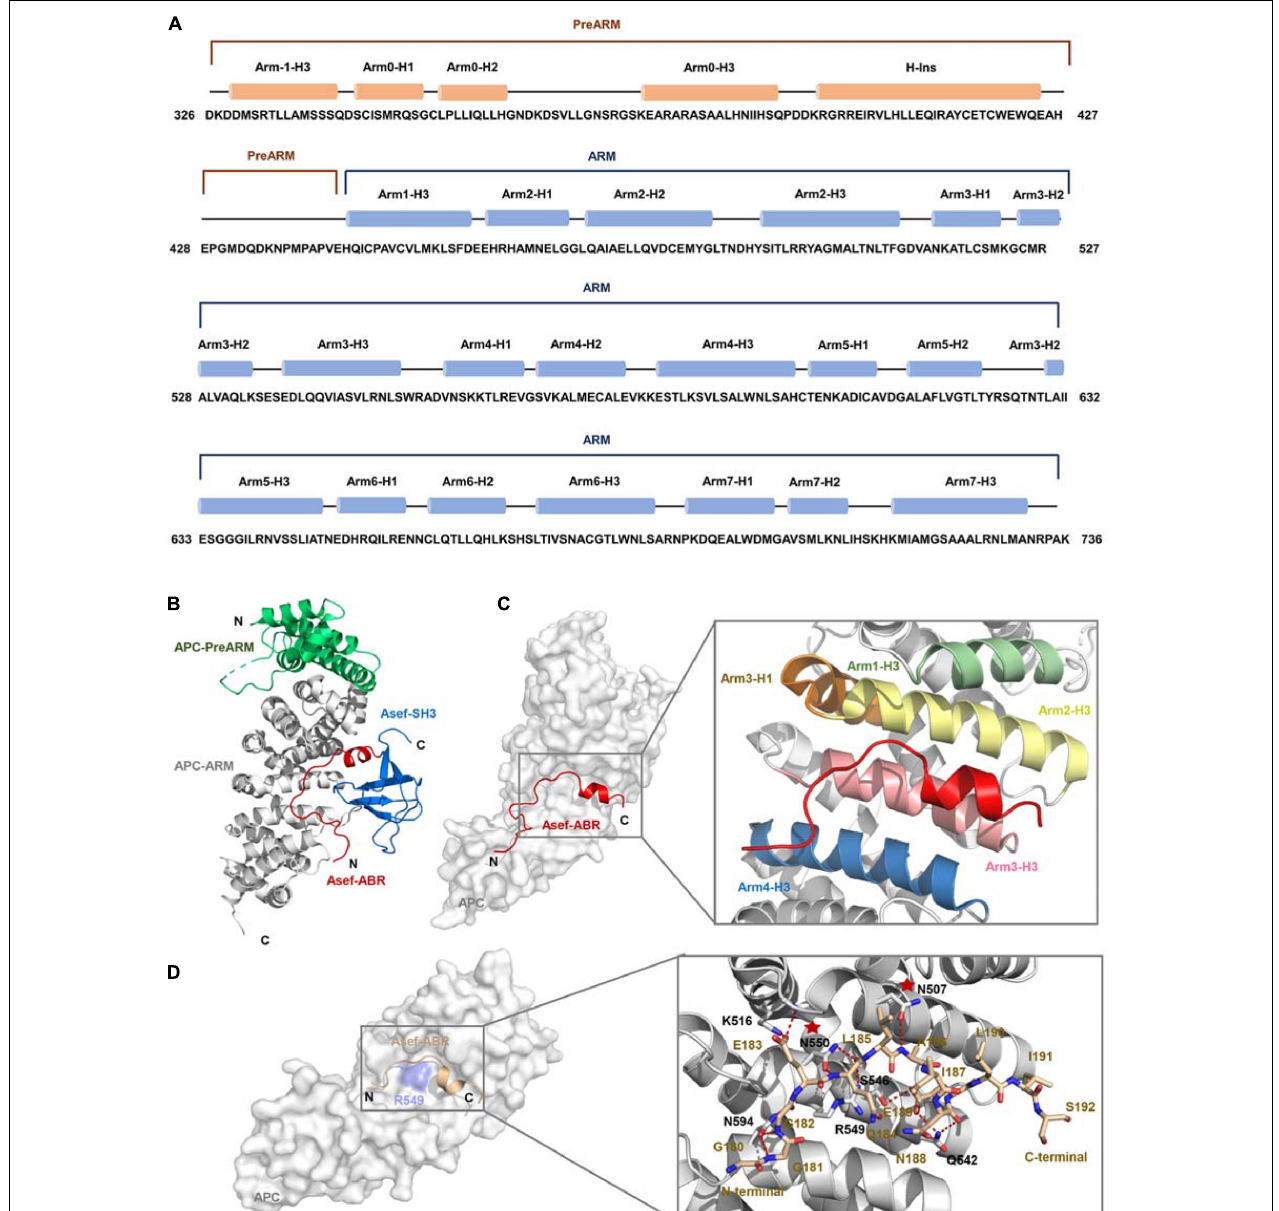
FIGURE 3 | The crystal structure of APC and Asef (A) Sequence of human APC (residues 326-736). APC-PreARM residues (326-442) are labeled orange, and APC-ARM (453-767) are labeled blue. APC-PreARM consists of five α helices: Arm-1-H3, Arm0-H1, Arm0-H2, Arm0-H3, and the long helix insertion (H-Ins). APC-ARM contains seven armadillo repeats Arm1 to Arm7. (B) APC (PreARM-ARM)/Asef (ABR-SH3) complex structure, the PreARM portion of APC is shown in green, and the ARM portions of APC are shown in gray. The ABR domain of Asef is shown in red, and the SH3 domain of Asef is shown in blue. (C) Detailed information of the interface of APC and Asef complex. Asef is shown in red. Arm1-H3, Arm2-H3, Arm3-H1, Arm3-H3, and Arm4-H3 are shown in green, yellow, orange, pink, and blue, respectively. (D) Left: The interactions of APC and Asef-ABR. The ABR domain of Asef is shown in champagne, and APC is shown in gray. Right: Close-up view of interactions between APC and Asef. APC is shown as a gray carton, and Asef is shown as a champagne stick. Red dashed lines represent hydrogen bonds. The red stars represent APC-Asn507 and APC-Asn550 are critical in the interaction of APC and